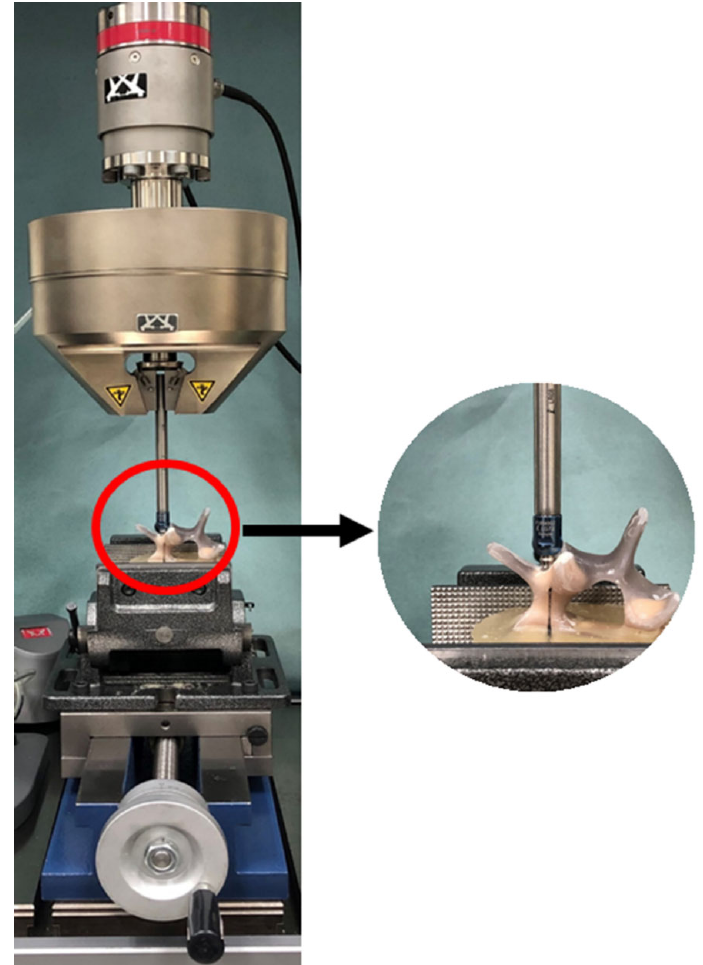
Figure 3. Photographs showing the complete experimental setup for the screw pullout test. The polyaxial screw head was fixed to a 10-mm diameter cylindrical rod with an outer thread that matched the inner thread of the screw head cup. The cylindrical rod was then clamped to the upper wedge grip of the Instron testing machine. The potted specimen was clamped on a lower custom-made grip capable of x–y plane translation and rotation to achieve the coaxial alignment of the pedicle screw with the pullout ram.